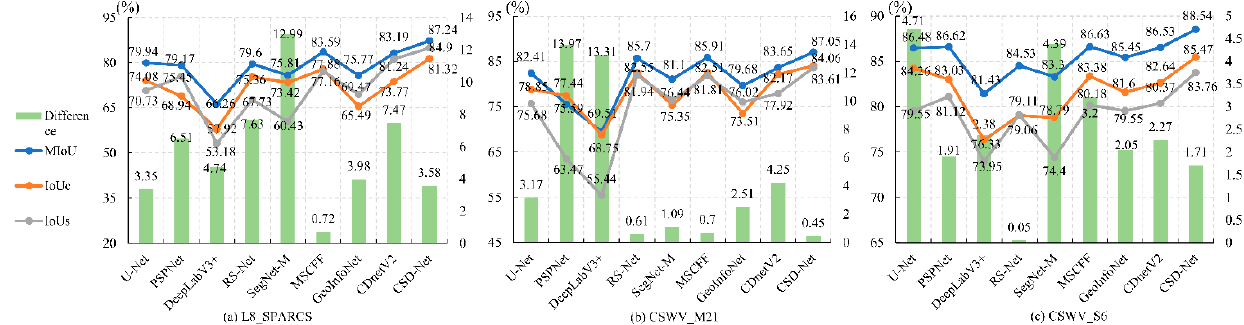
Figure 14. The MIoU, IoUc, and IoUs of different methods. Meanwhile, the absolute difference between IoUc and IoUs was calculated and shown. ( a – c ) The comparison of results on L8_SPARCS, CSWV_M21, CSWV_S6, respectively.